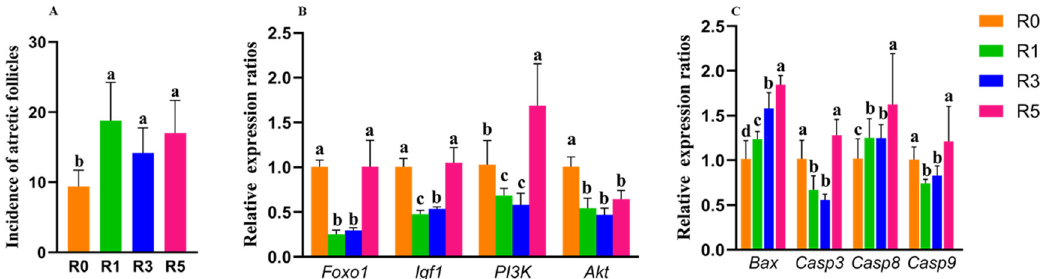
Figure 6. Effects of repeated superovulation on granulosa cell apoptosis. ( A ), average number of follicular atresia in ovaries; ( B ), the expression of genes related to anti-apoptosis in granulosa cells; ( C ), the expression of genes related to apoptosis in granulosa cells. The same letters mean the statistical difference was not significant between groups ( p > 0.05, unpaired t -test); different letters mean the statistical difference was significant between groups ( p < 0.05, unpaired t -test).